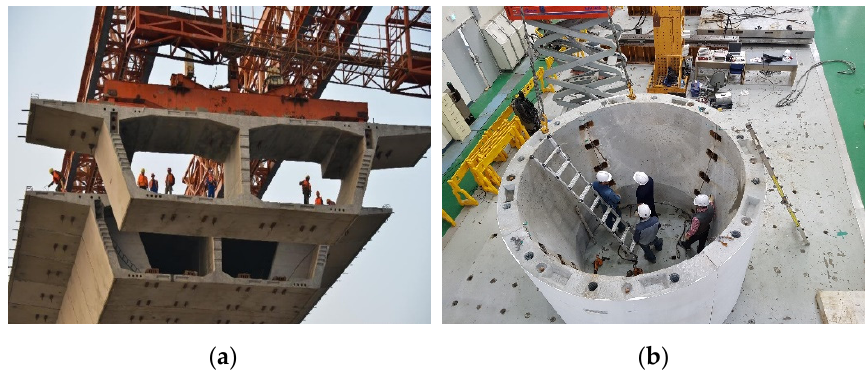
Figure 1. Examples of precast concrete construction: ( a ) prestressed concrete box-girder bridge; and ( b ) wind tower [18].